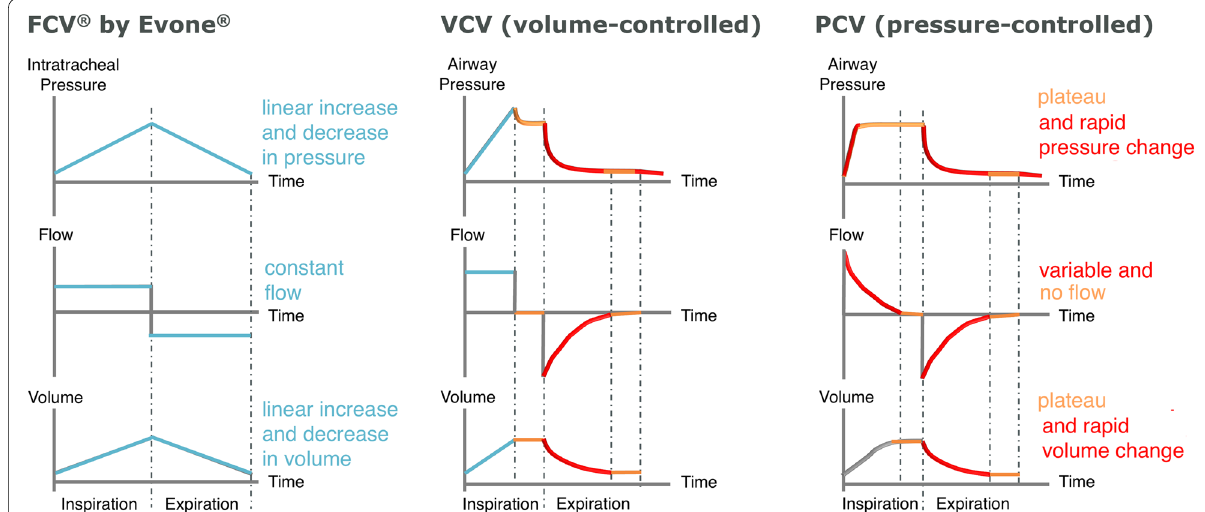
Fig. 3 Flow-controlled ventilation (FCV) compared to volume-controlled ventilation (VCV) and pressure-controlled ventilation (PCV). FCV requires a high resistant breathing circuit to prevent passive expiration and to fully control ventilation. FCV is a fully dynamic ventilation providing stable gas flow into and out of the patient lungs, without frequent phases of no-flow. FCV aims for linear increases and decreases in intratracheal pressures, with no sudden pressure drops at the beginning of expiration, and constant flows during inspiration and